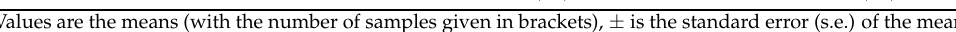
Values are the means (with the number of samples given in brackets), ± is the standard error (s.e.) of the mean.